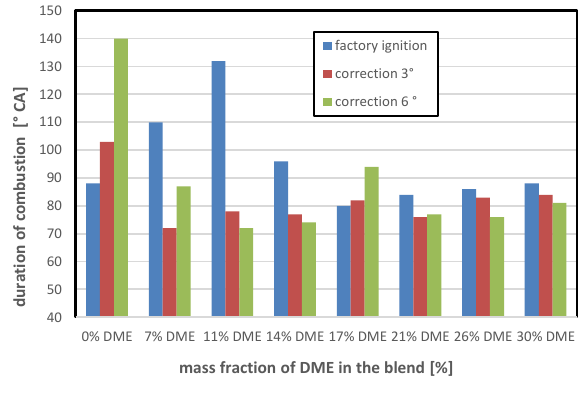
Fig. 6. Summary of the duration of combustion processes for the engine speed of 3000 rpm, fueled with LPG-DME mixtures, with the correction of the ignition angle. Engine load 33%